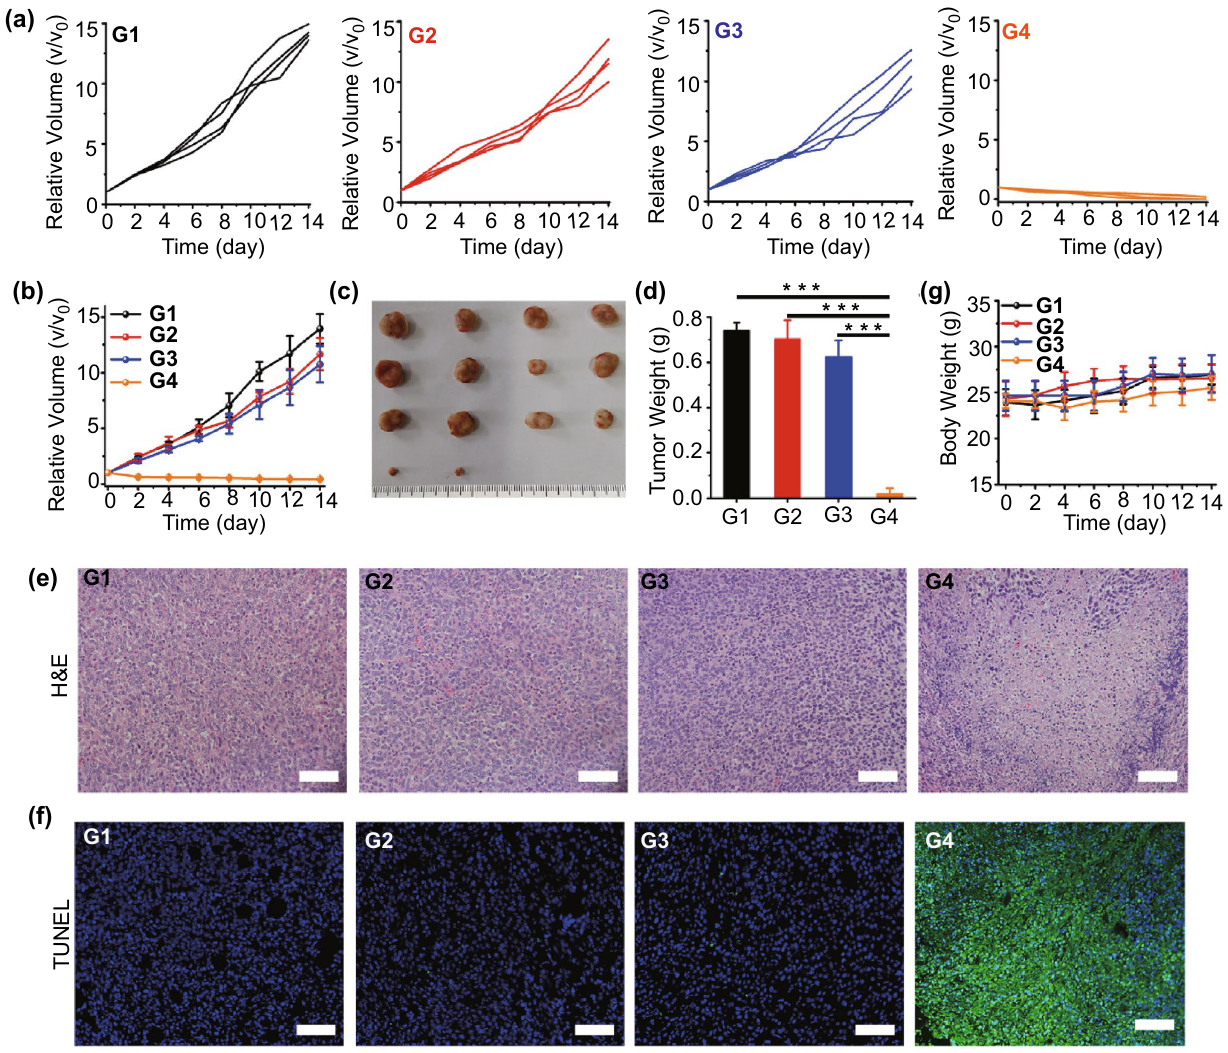
Fig. 5 a Individual tumor growth profiles: (G1) control, (G2) NIR, (G3) SnNSs@PEG, (G4) SnNSs@PEG + NIR. b Average tumor growth pro‑ files for all treatment groups. c Digital images of tumors in after various treatments. d Average tumor weight for all treatment groups. e HE and f TUNEL staining of tumor slices after the treatments (scale bar = 40 μm). g Body weight changes in each group during